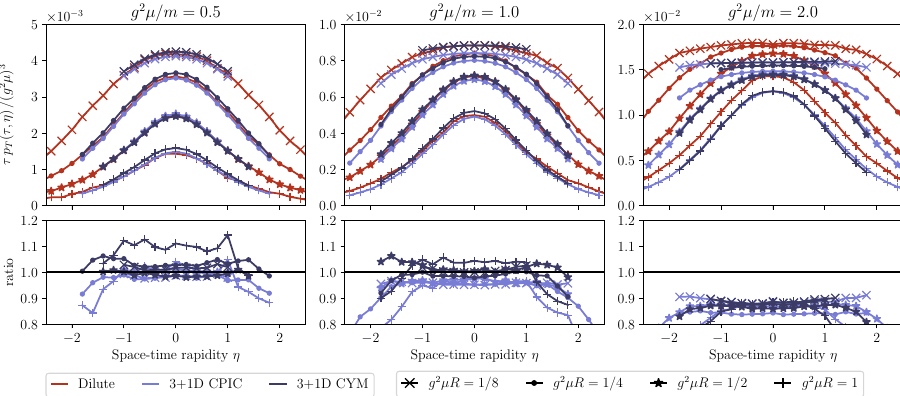
Figure 3. Rapidity profiles of transverse pressure as a function of space-time rapidity η in the coherent limit ξ = 2 R for various values of the longitudinal width R and the non-linearity parameter g 2 μ/ m at late times τ (cid:12) R . The red line corresponds to the weak field approximation, whereas the two purple lines correspond to two di ff erent lattice implementations (3 + 1D colored particle-in-cell (CPIC) [7] and 3 + 1D classical Yang-Mills (CYM) using dynamical currents [8]). Both the magnitude and the rapidity dependence are well described by the weak field approximation for small fields g 2 μ/ m (cid:2) 1 (left and center panels), but the weak-field pressure is generally overestimated in the more non-linear case (right panel). Nevertheless, the rapidity profile is still correctly reproduced for larger g 2 μ/ m as can be seen from the bottom panels, where we show the ratio of the weak field approximation to the lattice simulations. Adapted from [9].